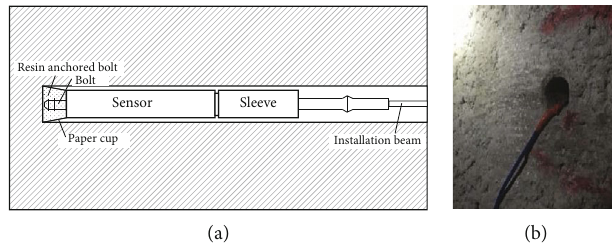
Figure 22: Sketch map of installing sensor in the drilling hole.